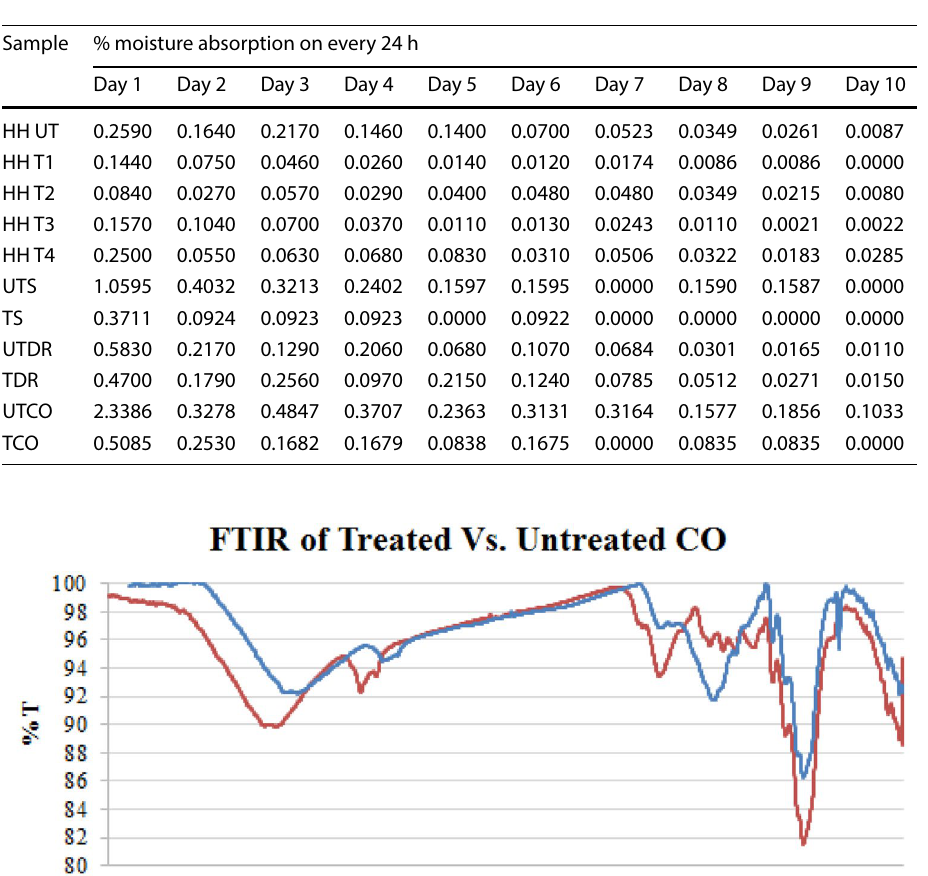
after alkali treatment